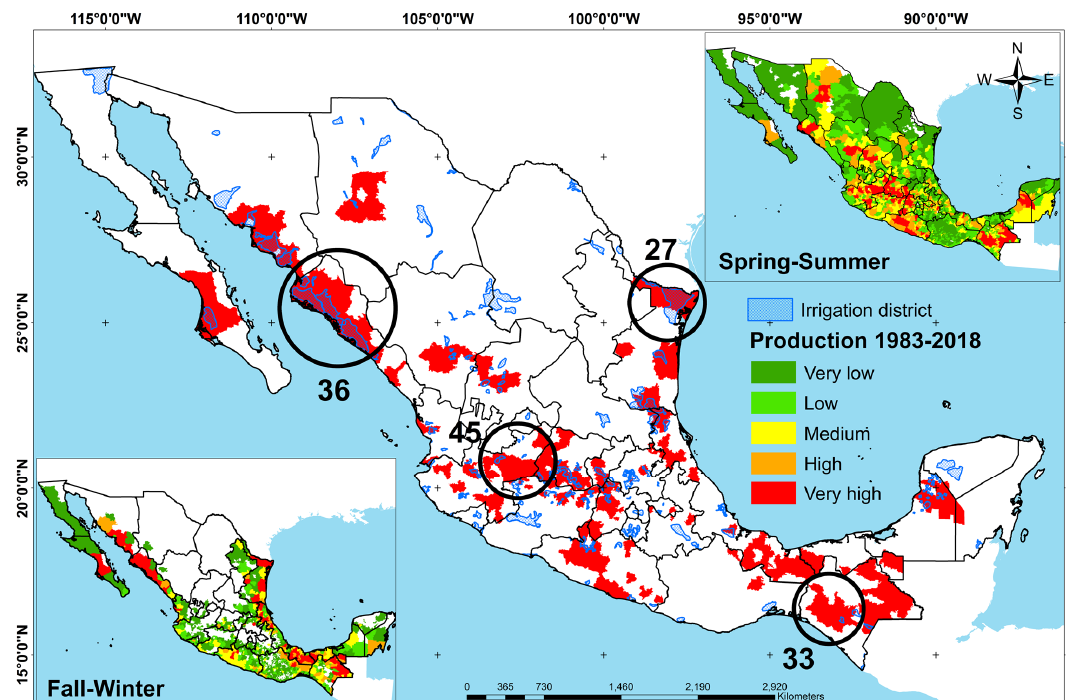
Figure 4. Main maize-producing zones in Mexico from 1983 to 2018 obtained from the sum of the production at the municipal level in the spring–summer and fall–winter cycles [19]. The circles indicate the regions where surveys were applied to key producers: Jalisco (45), Chiapas (33), Sinaloa (36) and Tamaulipas (27). Table 7. Socioeconomic characterization of the producers in the main maize-producing regions in Mexico from 1983 to 2018. Year Surface (ha) Region n